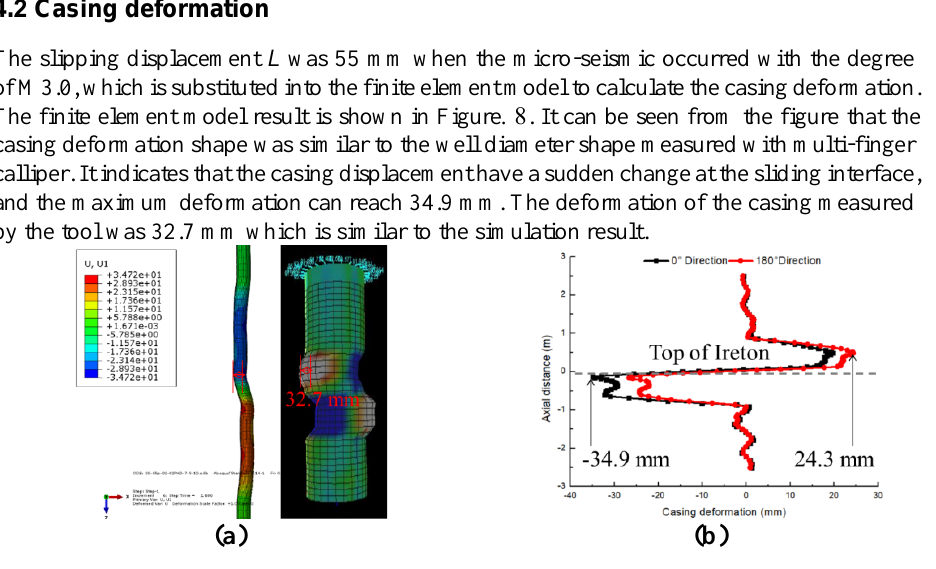
Fig. 8 . Comparison of finite element results and calliper measurement: (a) Comparison of finite element and borehole diameter measurement (b) Axial deformation of finite element.